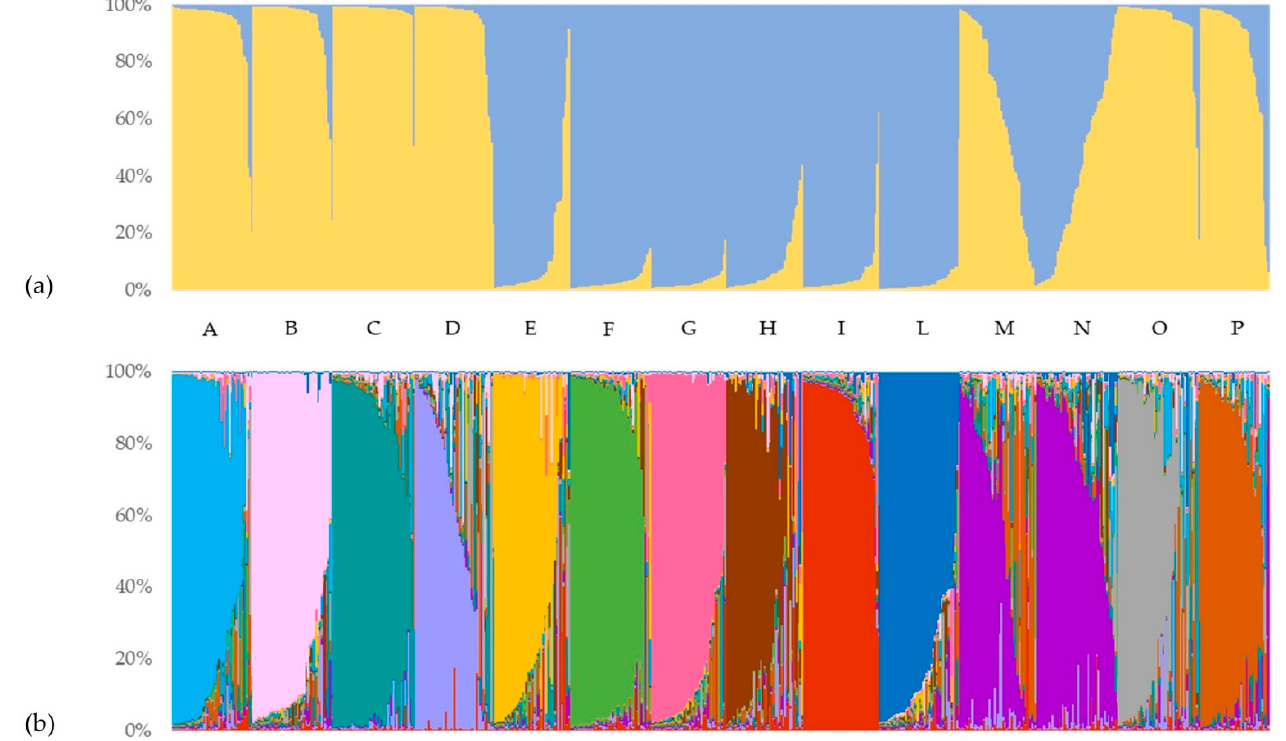
Figure 4. Genetic structure analysis of the Italian ryegrass core collection. Identified most likely value of K = 2 ( a ) and K = 13 ( b ). Clusters and samples’ memberships (indicated by different colors) agree with the variety to which they belong, identified by different letters.